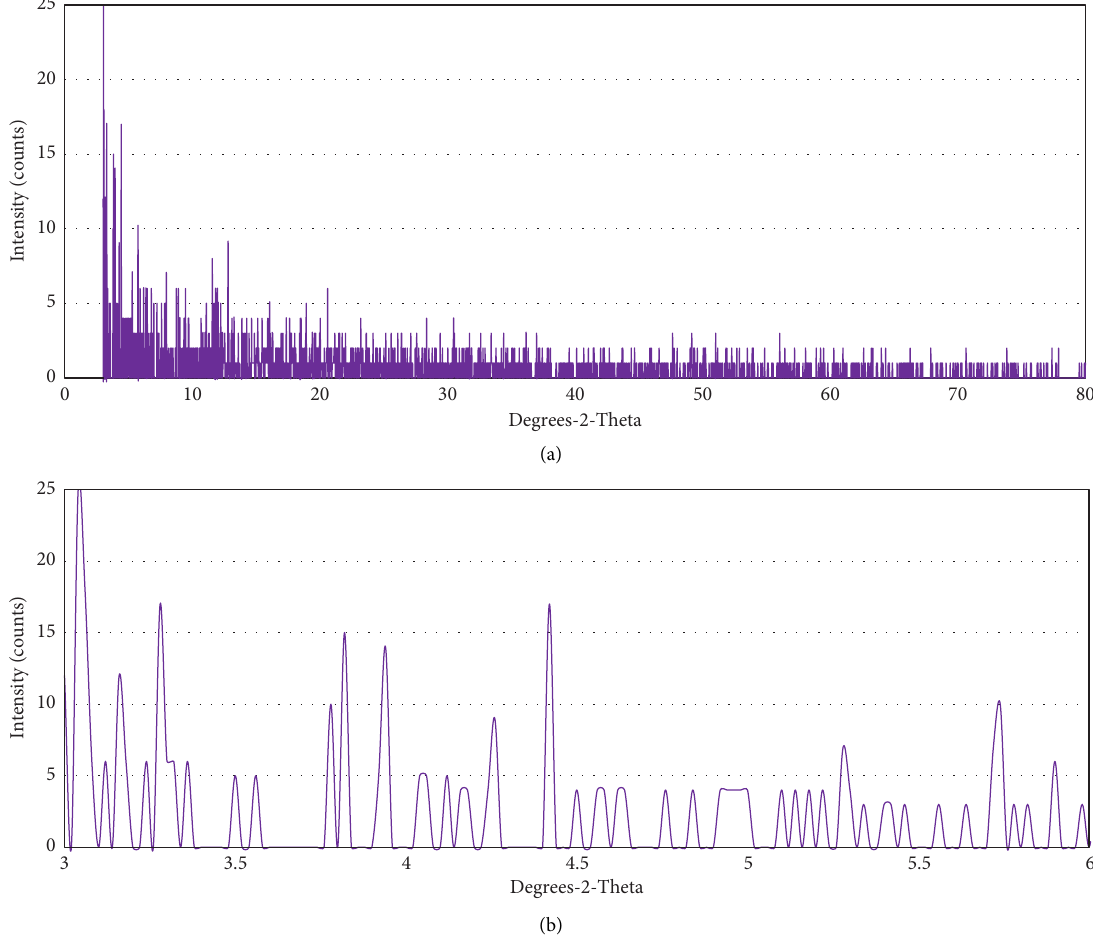
Figure 15: XRD micrographs for BFRC. (a) Characteristic patterns in the 2 θ range between 3 ° and 80 ° . (b) Higher characteristic peaks in the 2 θ range between 3 ° and 6 °